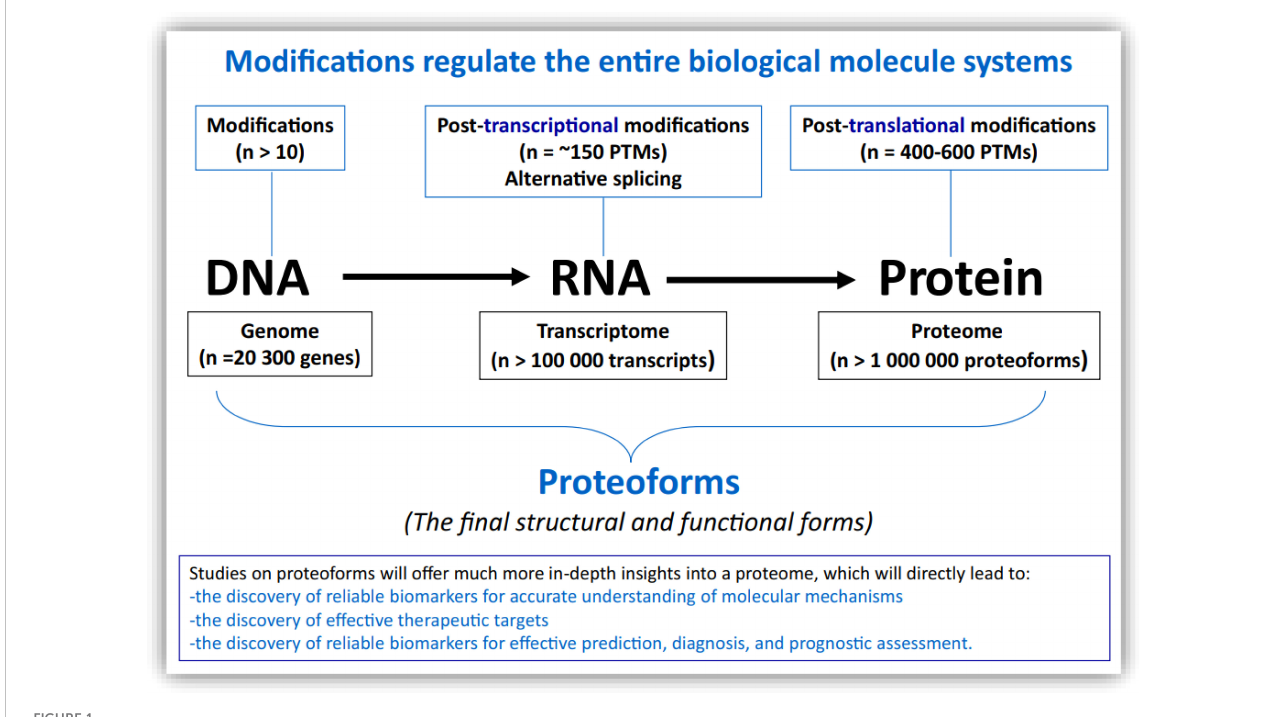
FIGURE 1 The relationships between biomolecular modi fi cations in DNA, RNA, and protein, and the proteoforms that constitute the end-point structural and functional forms of a gene or protein. Constructed from Li, Desiderio, and Zhan (1) with copyright permission from Wiley, and from Zhan, Long, and Lu (3) with copyright permission from Elsevier. Reproduced from Zhan X et al. (2) with copyright permission from Springer